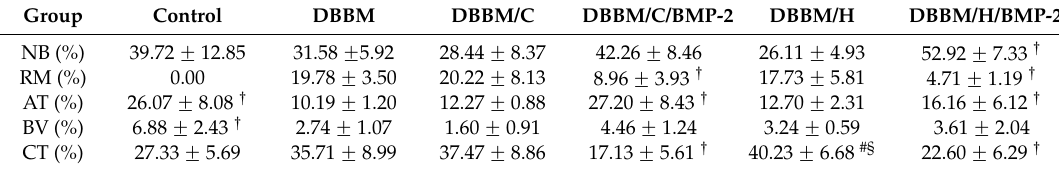
Figure 6. Histologic analysis of the beagle extraction ‐ socket model. ( A ) Low ‐ magnification image of the extraction site after eight weeks of healing (Masson’s trichrome staining, original magnification ×40, scale bar = 5 mm). While control sites showed a significant decrease in alveolar bone width at the coronal half of the dental root length, buccal bone plates at the other five grafted sites were in a higher position than at the control site; ( B ) Representative high ‐ magnification view of the coronal region of the augmented area (Masson’s trichrome staining, original magnification ×100, scale bar = 400 μ m); ( C ) A twofold ‐ enlarged image in the center of ( B ) (Masson’s trichrome staining, magnification ×200, scale bar = 200 μ m). Sites that received rhBMP ‐ 2 appeared to be in a more mature healing phase and showed higher proportions of adipose bone marrow tissue compared to the other three grafted sites, in which dense connective tissue could be found instead of adipose bone marrow tissue. DBBM, deproteinized bovine bone mineral; C, absorbable collagen sponge; BMP ‐ 2, bone morphogenetic protein ‐ 2; HA, hydroxyapatite ‐ coated collagen; NB, newly formed bone; RM, residual material; AT, adipose tissue; BV, blood vessel; CT, connective tissue. Table 2. Histomorphometric results in extraction ‐ socket grafting model: proportion of composition of the augmented area (mean ± SD values).